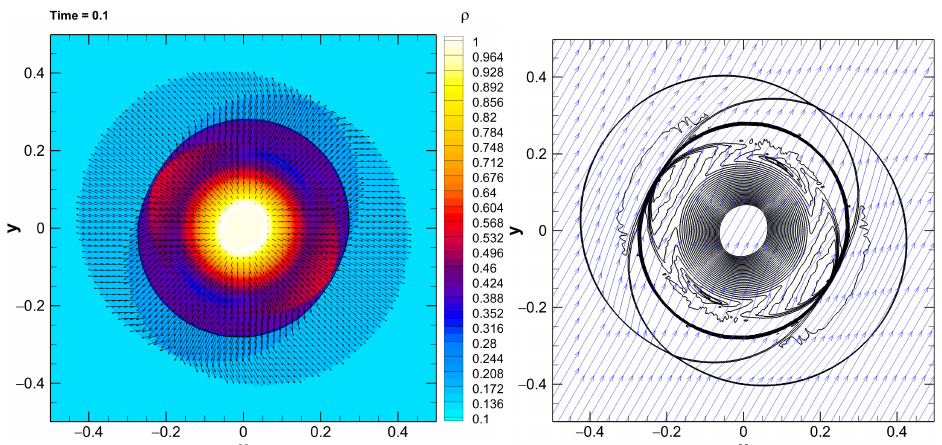
Figure A2. The results of the test calculation of the problem on a volume-distributed explosion in a homogeneous magnetic field. The density (color) and velocity distributions (arrows) are shown on the left. The solid line corresponds to the border of the cloud. The density distributions (iso-lines) and magnetic field distributions (lines with arrows) are shown on the right. The distributions of the quantities are presented at time moment t =